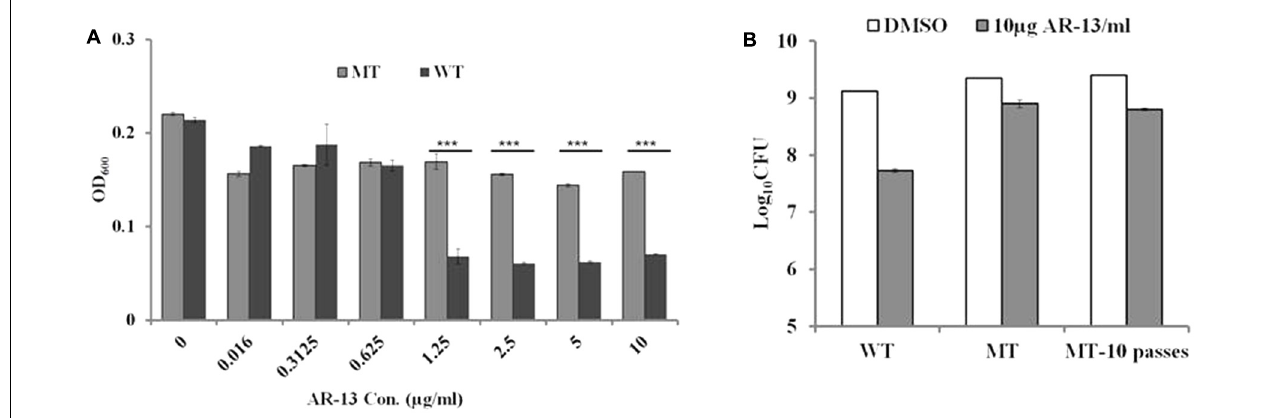
FIGURE 4 | Stability of AR-13 resistance. (A) Growth curve of LVS (WT) and the LVS AR-13 resistant mutant (MT) in the presence of various concentrations of AR-13 in mTSB. WT or MT were grown in twofold serial dilutions of AR-13 with a starting concentration of 10 µ g/ml. Optical densities at 600nm (OD 600 ) were measured by a plate reader at 18 h after inoculation. (B) AR-13 resistance is stable. Approximately 1.5 × 10 9 CFU of WT or MT after 10 overnight passes in AR-13-free mTSB (MT-10 passes) were incubated in 1 ml PBS containing 10 µ g AR-13. Viable bacteria were evaluated at 3 h post-treatment by serial dilution and plating. Data were representative of 2–4 independent experiments each performed in triplicate; ∗∗∗ p < 0.001; NS, not significant.